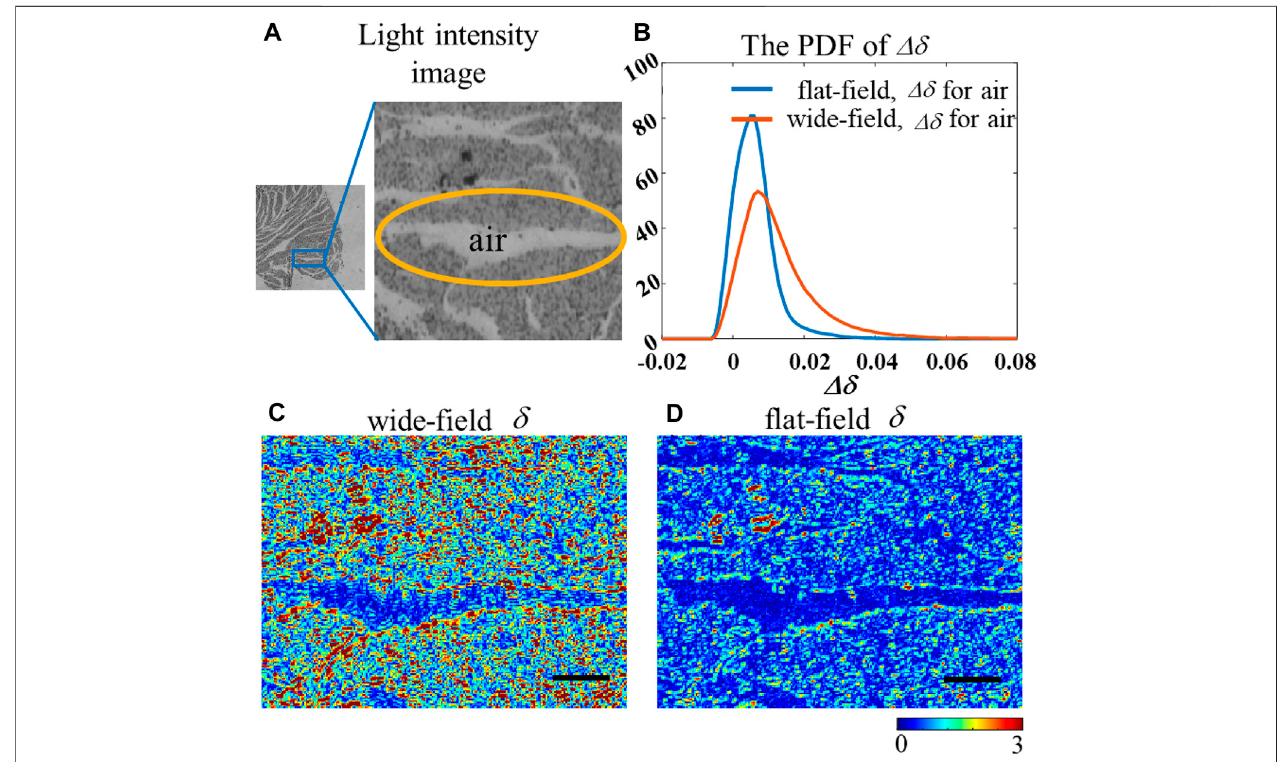
FIGURE9|(A) Lightintensityimageofthesample,thecircledareaisthegapbetweenthesamples; (B) PDFofthelinearretardancedeviationcalculatedinthegap; (C – D) 2D images of the δ under wide- fi eld and fl at- fi eld, respectively. The black scale bar is 100 μ m.